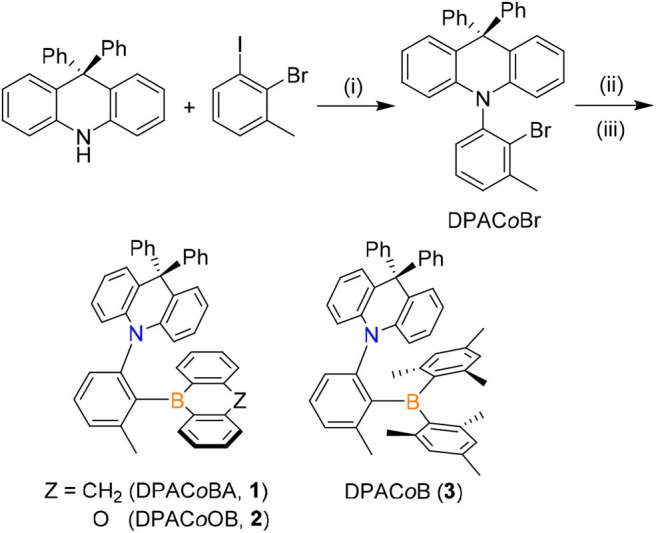
Synthesis of ortho-DPAC-appended triarylboron compounds (1–3). Conditions: (i) Pd2(dba)3, P(tBu)3, NaOtBu, toluene, 110°C. (ii) n-BuLi, ether, −30°C. (iii) Ar2BX (9-bromo-9,10-dihydro-9-boraanthracene for 1; 10-bromo-9-oxa-10-boraanthracene for 2; dimesitylboron fluoride for 3), toluene, −78°C.